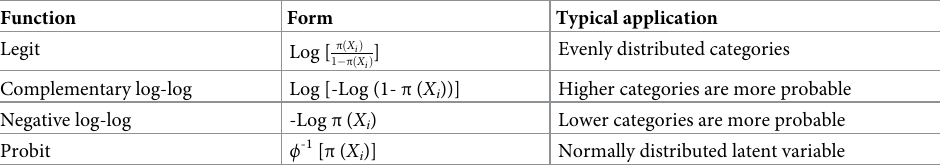
Table 2. Link function for the logistic regression